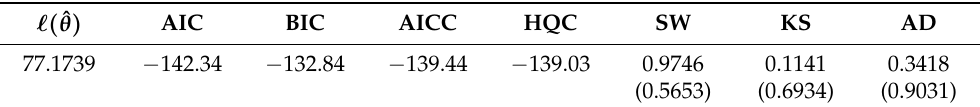
Table 8. Comparison criteria and Shapiro–Wilk, Kolmogorov–Smirnov and Anderson–Darling normality